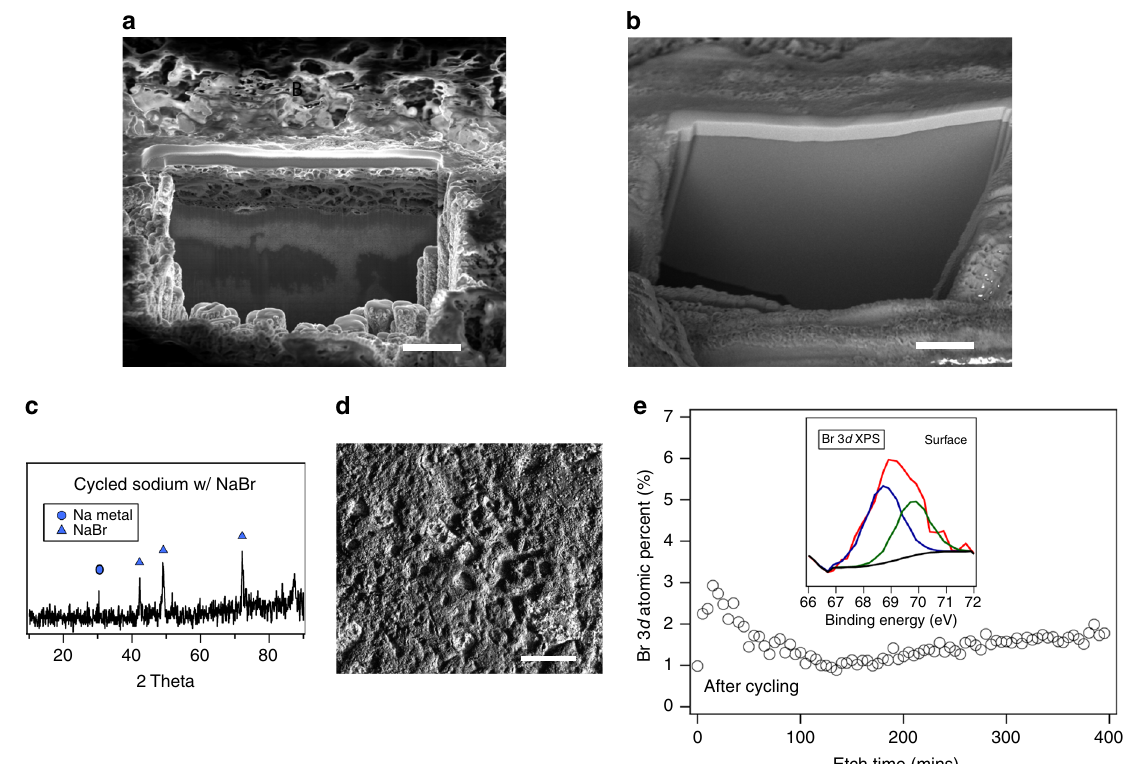
Fig. 3 Air sensitivity and stability of sodium bromide interphase. a Milled region on pristine sodium metal obtained using focused ion beam milling at room temperature. The porous layer indicates severe oxidation of sodium during sample transfer; scale bar , 5 µ m. b Same as a but with NaBr coating. In both ( a , b ) the thin top solid layer is a platinum protective coating, deposited inside the FIB prior to milling. c XRD showing intensity of Na metal and NaBr peaks for sodium anode with NaBr coating and after cycling at 0.5 mA cm − 2 for fi ve times in a symmetric sodium cell. d SEM image of NaBr-coated sodium metal anode after cycling; scale bar , 200 µ m. e Depth pro fi ling of cycled anode obtained by ion etching and XPS measurements. The atomic content of Br 3 d is shown as a function of etch time. The etching rate is ~5nm/min. The inset shows the Br 3 d XPS result for the cycled sodium anode surface (before